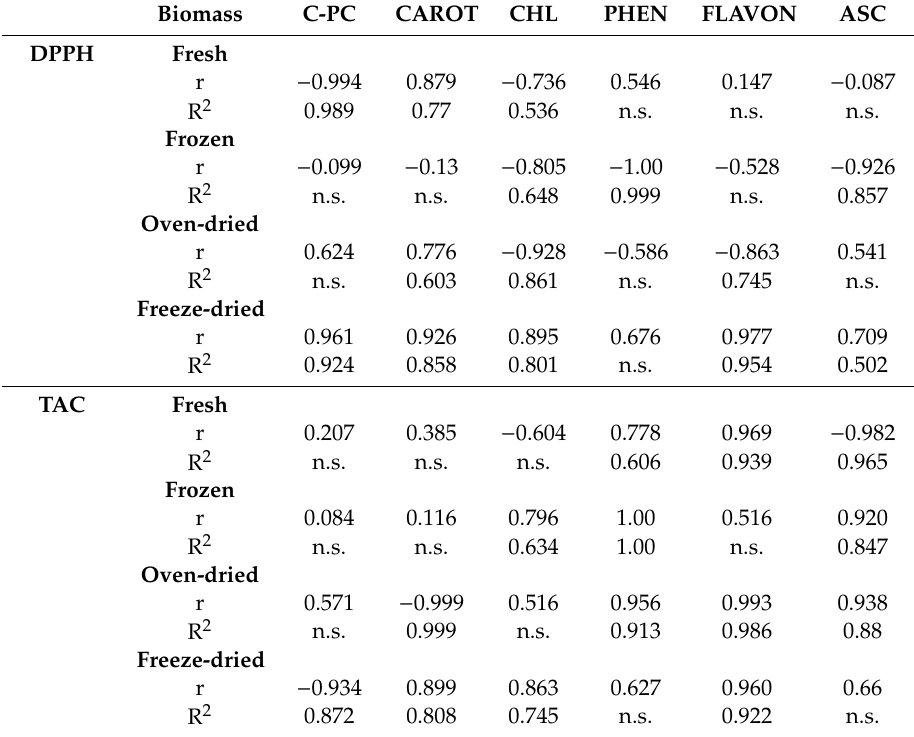
C-PC, phycocyanin C; CAROT, carotenoids; CHL, chlorophyll a; PHEN, total phenols; FLAVON, total flavonoids; ASC, ascorbic acid.